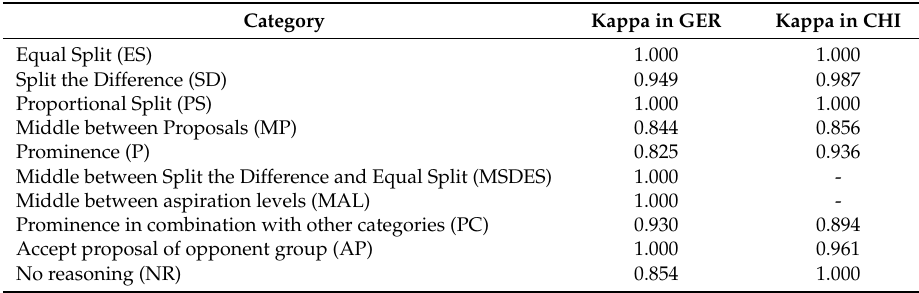
Table A1. Values of Kappa in GER and CHI.